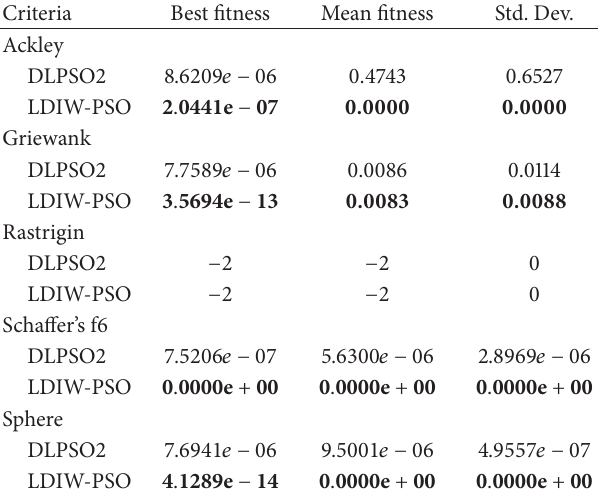
Table 8: Experimental results for LDIW-PSO compared with